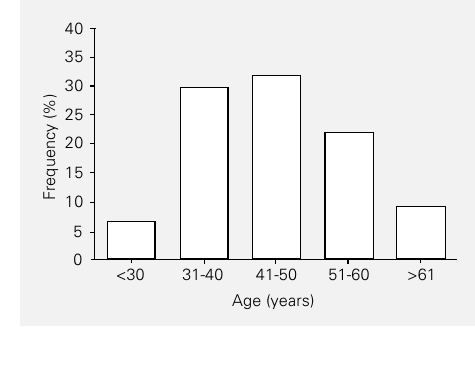
Figure 1 - Age distribution of 302 patients with stage Ib and IIa cer- vical cancer submitted to radical hysterectomy and lymphadenec- tomy. Mean age was 43 years.